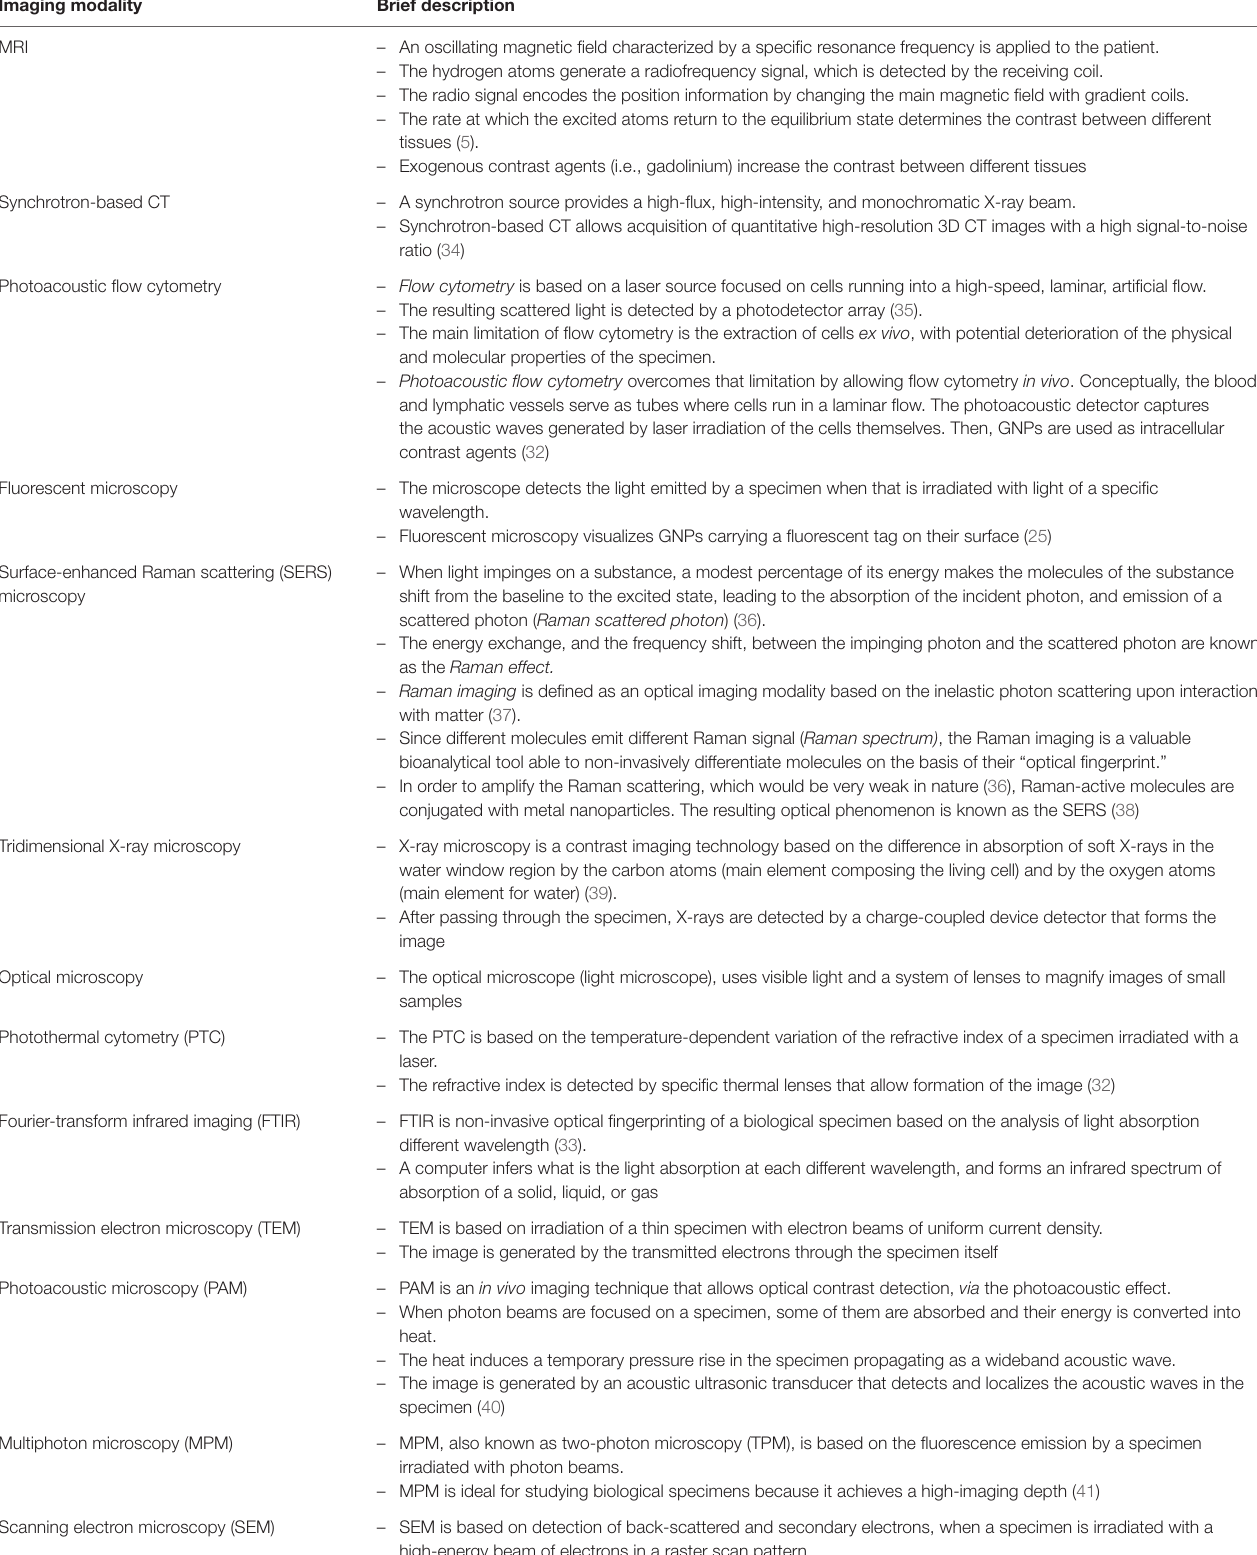
taBLe 5 | Reference guide for the imaging modalities used in conjunction with gold nanoparticles